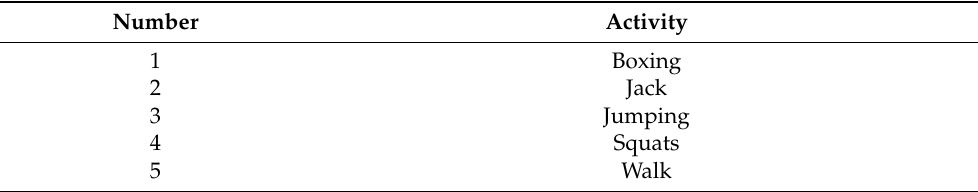
Table 2. The 5 activity types of the MMActivity dataset